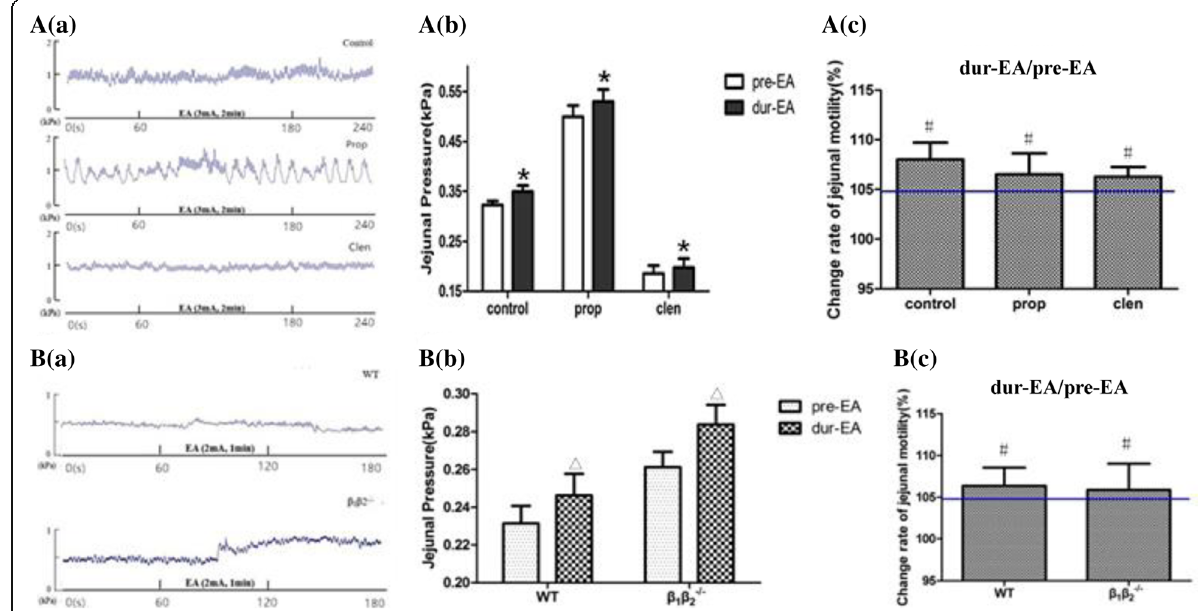
Fig. 3 Jejunal motility in response to EA at LI11 under the administration of the sympathetic pathway. Aa Representative tracings of jejunal motility regulated by EA without and with the administration of propranolol and clenbuterol in rats. Ab Compared with the jejunal pressure before EA, changes were observed during EA in the control group, propranolol group and clenbuterol group. Propranolol promoted jejunal pressure significantly and clenbuterol led to the opposite effect, whereas EA at LI11 increased jejunal pressure in all three groups, which had statistical significance. Data are expressed as mean ± SEM ( n = 8 rats per group at each time period). * P < 0.05 vs pre-EA, paired t -test. Ac Promotion percentages of jejunal pressure by EA in three rat groups are shown, and each change rate was above 105%. The promotion rate of EA was not significantly different among the groups. # P > 0.05 vs each group, One-way ANOVA. Data are expressed as mean ± SEM ( n = 8 rats and mice). Ba Representative tracings of jejunal motility regulated by EA in WT mice and β 1 β 2 − / − mice. Bb Compared with the jejunal pressure before EA at the same intensity, changes were observed during EA in both the WT and β 1 β 2 − / − groups. Thus, EA at LI11 increased jejunal pressure of both groups of mice significantly. Data are expressed as mean ± SEM ( n = 8 mice per group at each time period). Δ P < 0.05 vs pre-EA, paired t -test. Bc Promotion percentages of jejunal pressure by EA in two mouse groups are shown, and each change rate was above 105%. The promotion rate of EA was not significantly different among the groups. # P > 0.05 vs each group, One-way ANOVA. Data are expressed as mean ± SEM ( n = 8 rats and mice). EA, electroacupuncture; prop, propranolol; clen, clenbuterol. WT,